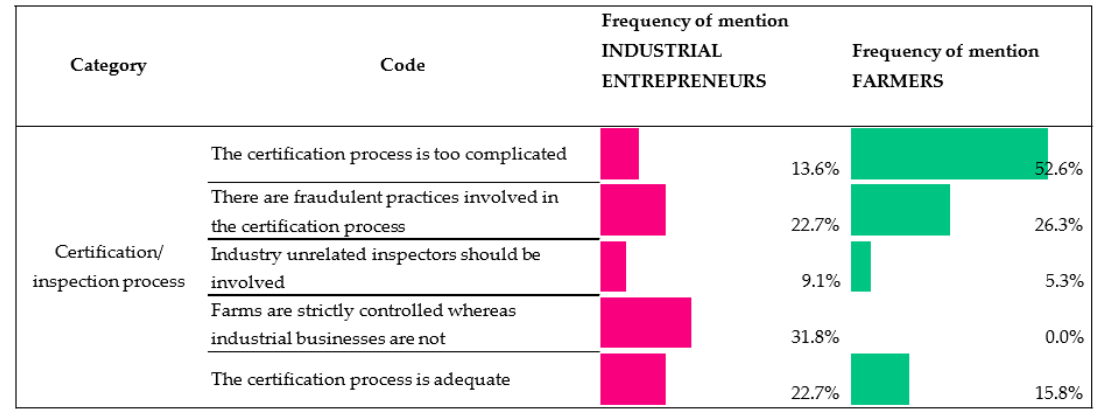
Figure 6. Industrial entrepreneur/farmer views on the requirements of the QS (Quality Standard) in terms of certification/inspection. (Scale: frequency of mention of each opinion. Percentage is based on responses in the given code out of all responses to equal 100%).